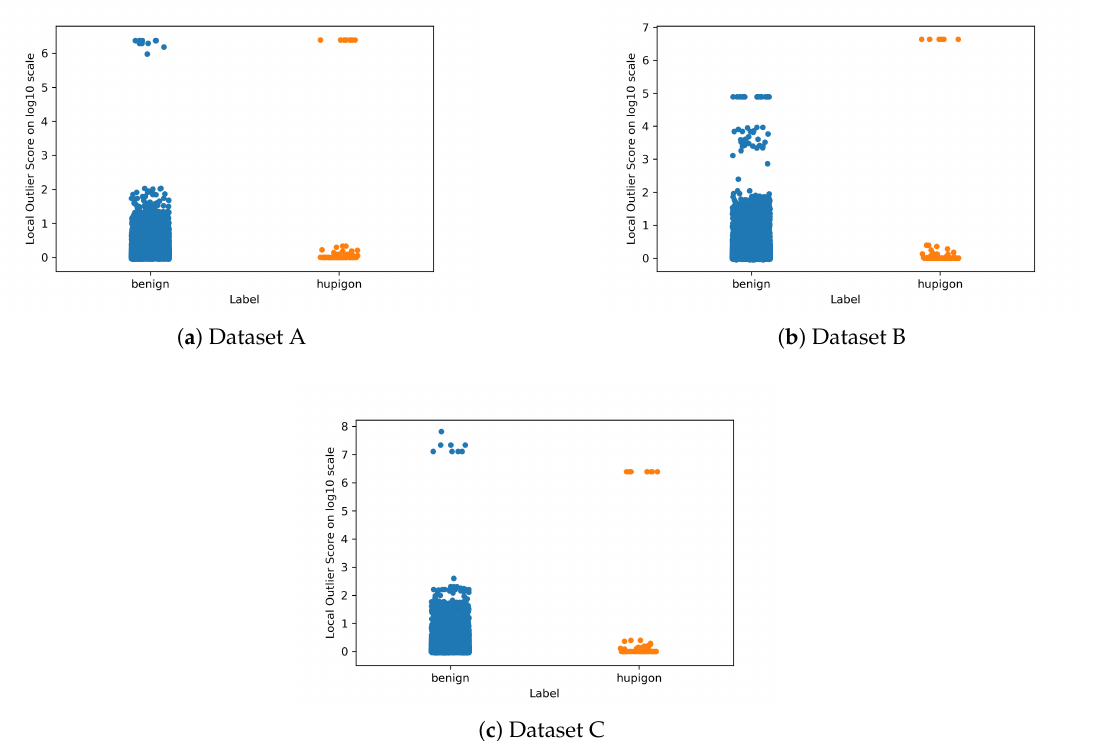
Figure 11. Local outlier score values of f 7 for the attack Hupigon